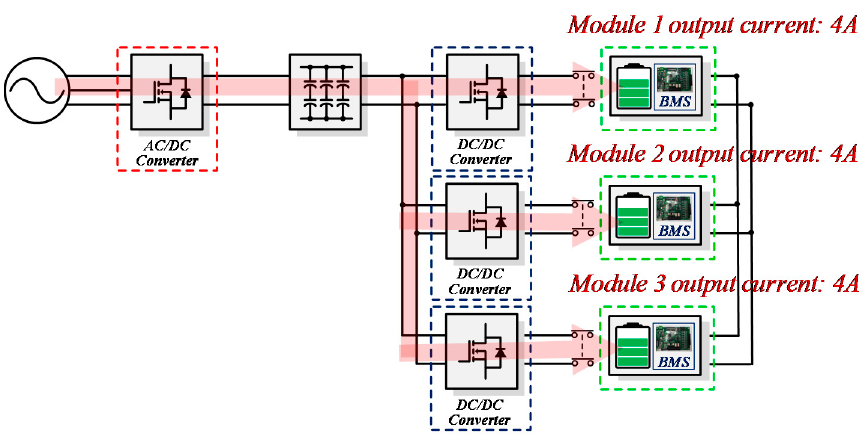
Figure 15. Current flow when modules are in the same SoC state.